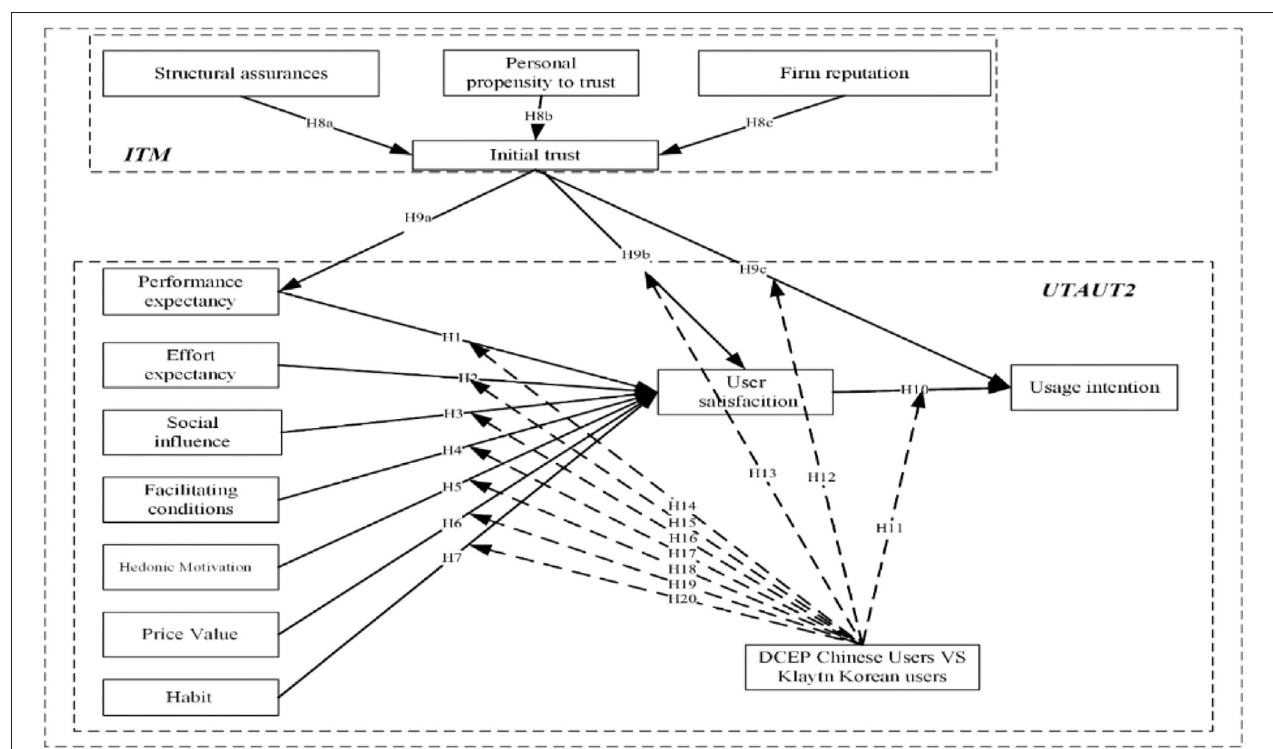
FIGURE 1 | Research